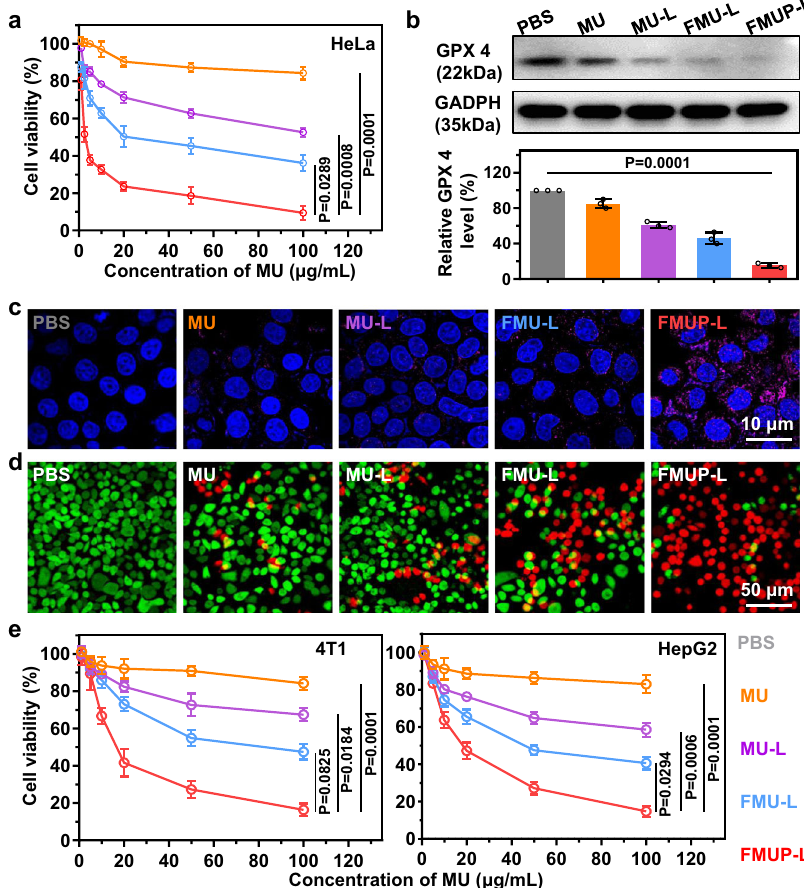
Fig. 5 The cytotoxicity of various treatments and the analysis of combined ferroptosis and apoptosis. a CCK-8 cytotoxicity analysis of HeLa cells treated with different formulations. b Western blotting analysis of glutathione peroxidase (GPX4) and GADPH. The samples derived from the same experiment and that blots were processed in parallel. c The analysis of caspase-3 activity in HeLa cells using Alexa 647-conjugated caspase-3 antibody. Pink: caspase- 3; Blue: nuclei. d Live/dead cytotoxicity analysis of HeLa cells treated with different formulations. Green: live cells; Red: dead cells. e CCK-8 cytotoxicity analysis of 4T1 and HepG2 cells treated with different formulations. Data in ( a ), ( b ), and ( e ) were represented as mean values ± SD, n = 3 biologically independent samples in ( a ) and ( b ), n = 4 biologically independent samples in ( e ). A representative image of three biologically independent samples from each group is shown in ( b – d ). P values were calculated by using one-way ANOVA in ( a ), ( b ), and ( e